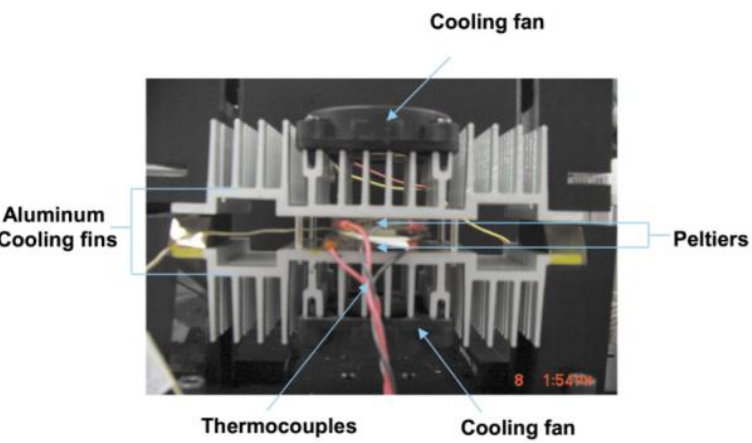
Figure 3. A picture of the chip included in the heating-cooling device. Reprinted with permission from [5]. Copyright 2002, Royal Society of